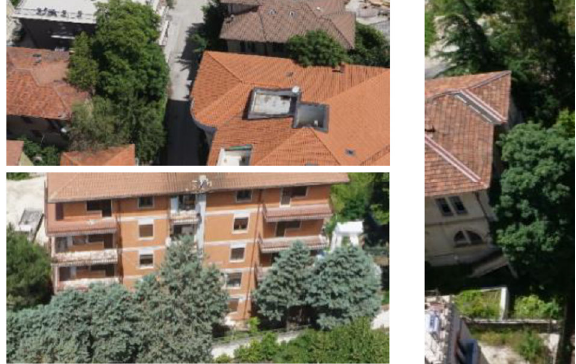
Figure 2. Problems for image processing posed by shadow and occlusion (Duarte et al.